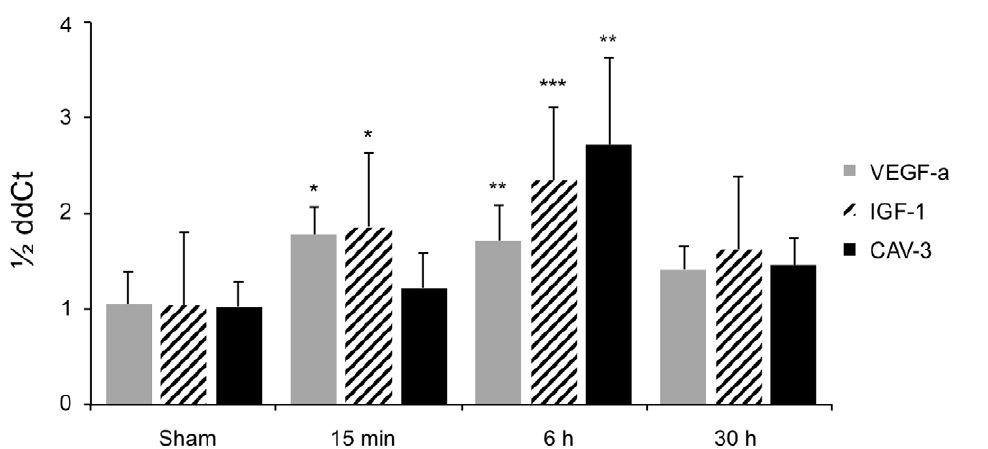
Figure 7. RNA-levels after UMS. UMS increases VEGF-a, IGF-1 and Cav-3 mRNA-levels within 15 min and reaches its peak expression after 6 hours. A prolonged upregulation could not be observed longer than 30 hours after UMS as compared to controls. The displayed p-values refer to the comparison with sham-treated animals.